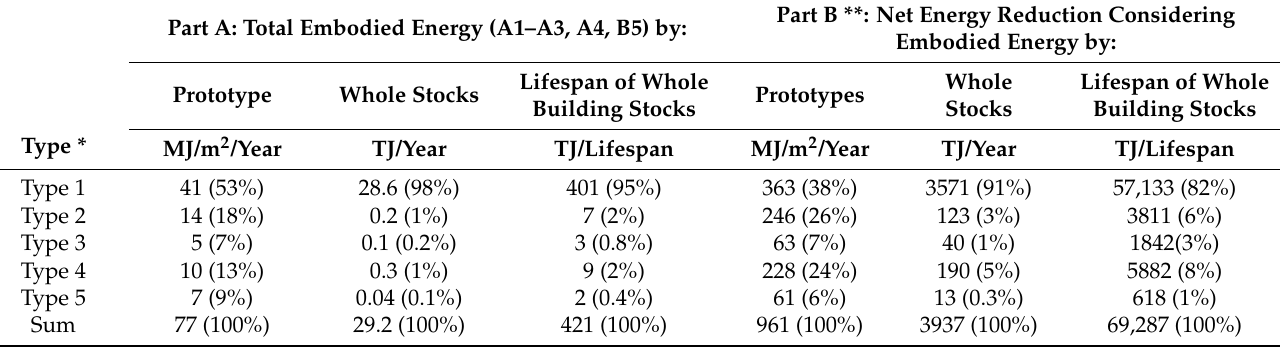
Table 9. Embodied energy and net energy reductions of building stocks in the City of Greater